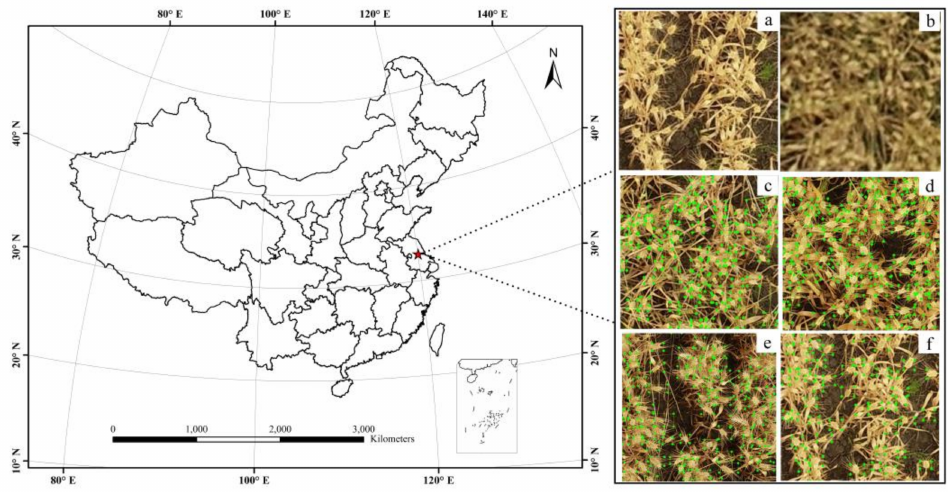
Figure 1. Experimental site and UAV wheat spike images: ( a ) clear image, ( b ) blurred image, ( c – f ) manually labeled images.